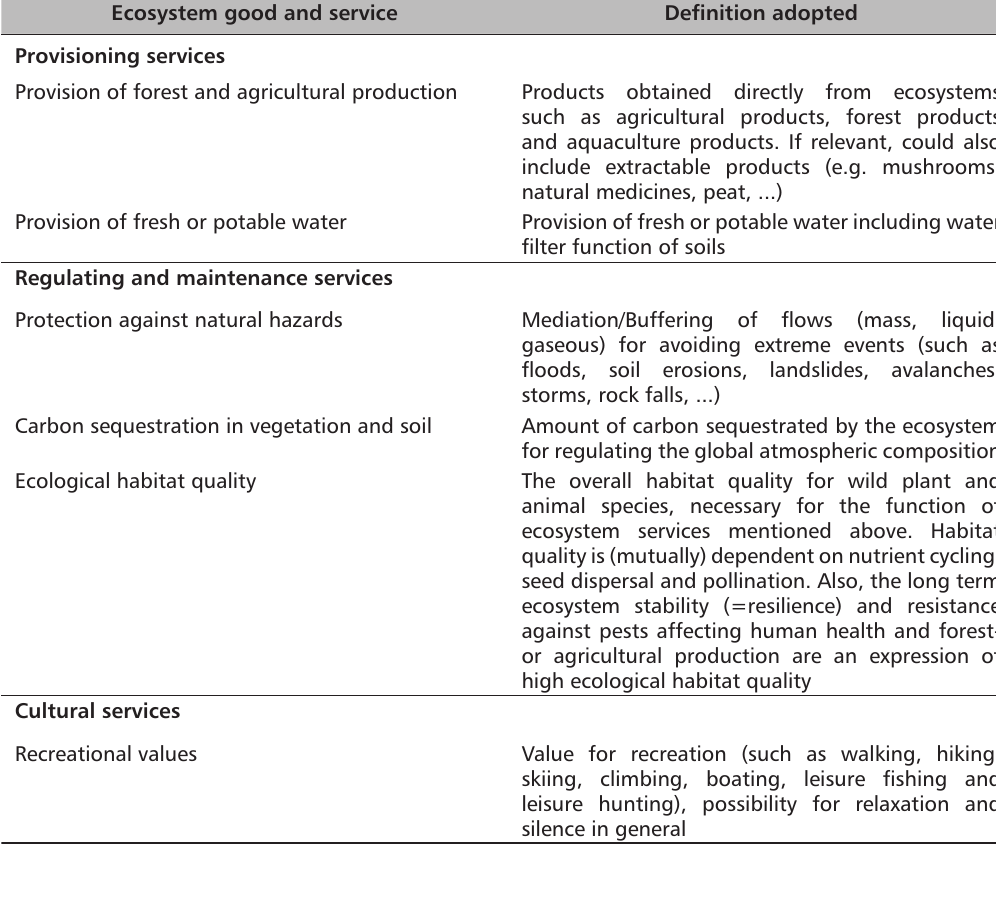
TABle 2. Alpine ecosystem goods and services considered in this paper (source: [20-22]) ecosystem good and